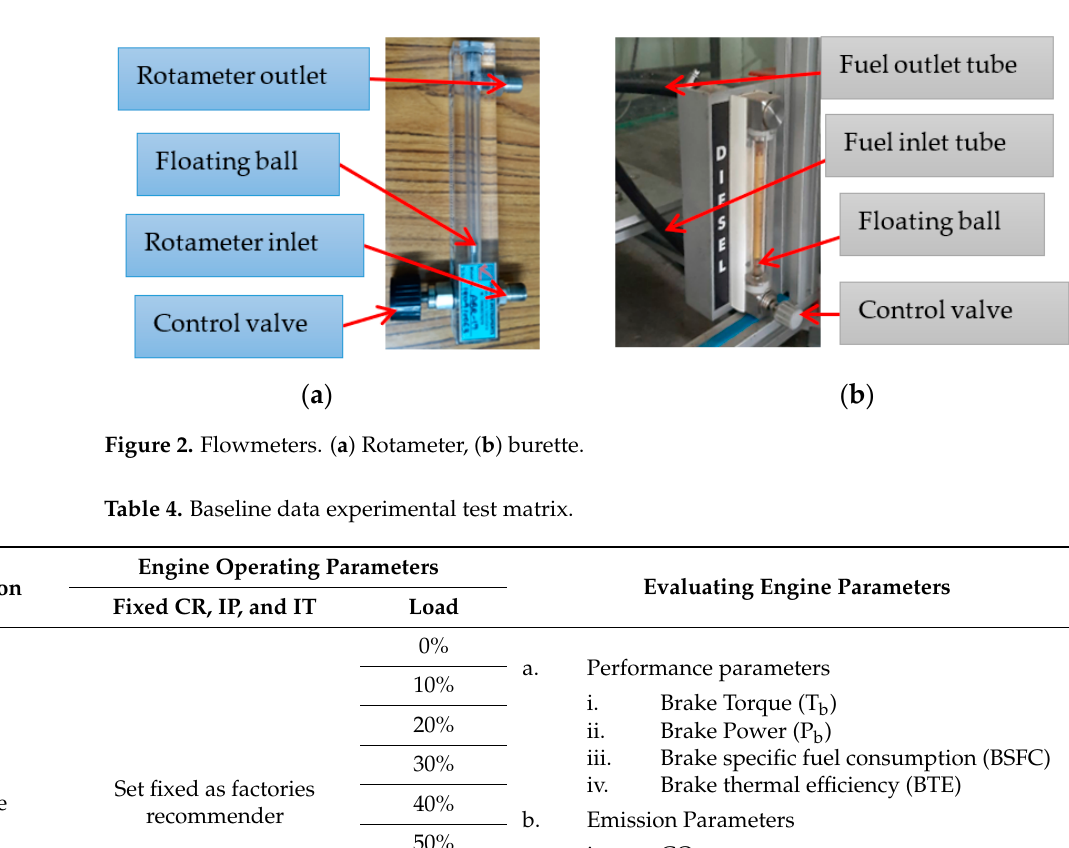
Table 3. Rotameter measurement range.